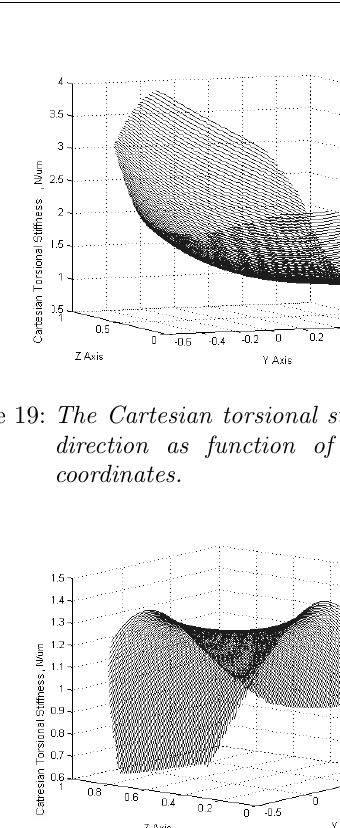
Figure 20: The Cartesian torsional stiffness in the Y- direction as function of the Y- and Z-